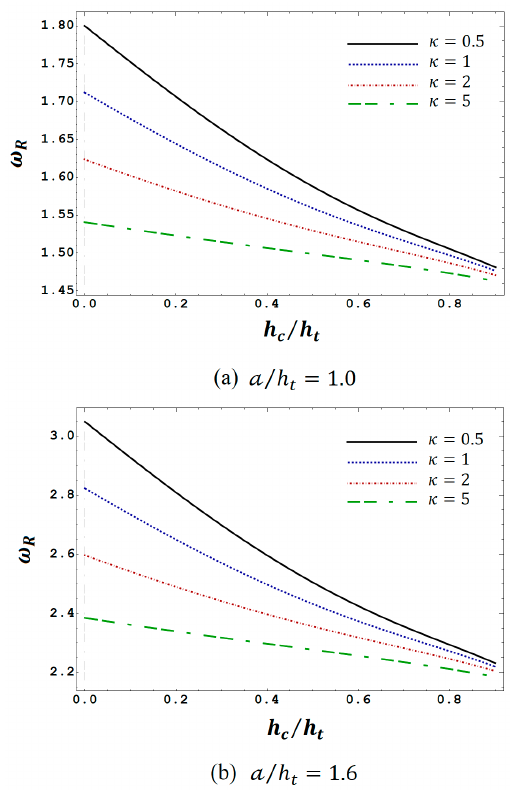
Figure 10. Variation of the first-order nonlinear-to-linear frequency ratio of a GPL-reinforced sandwich beam with respect to an increasing core-to-beam thickness ratio for di ff erent power-law parameters and amplitudes of vibration ( N = 10, Γ b = 1%, L / h t = 10 ).